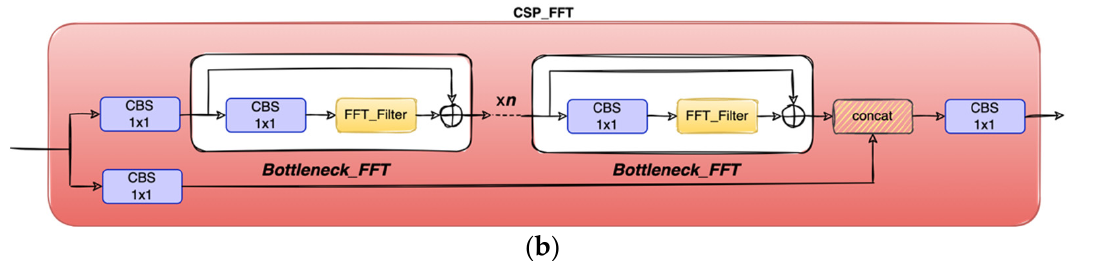
Figure 1. The framework of FFT_YOLOX, ( a ) the proposed modified YOLOX framework, ( b ) the proposed CSP_FFT block.